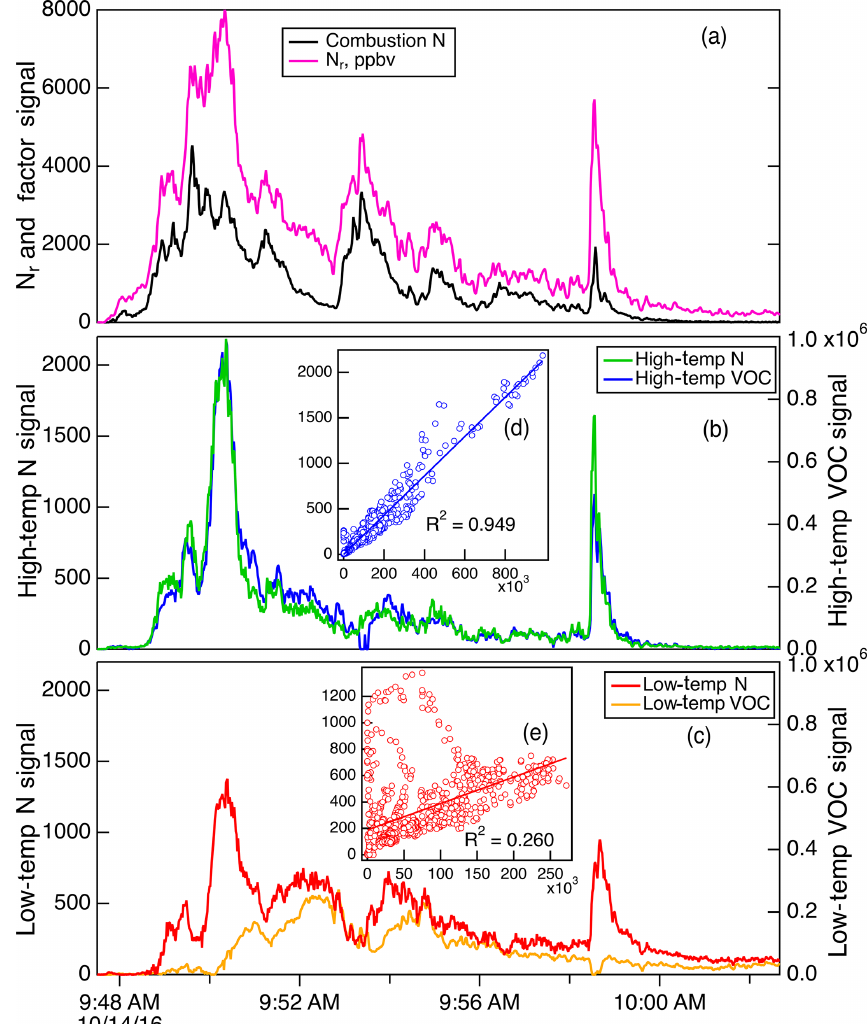
Figure 11. Details of the PMF factors for Fire 037 (ponderosa pine). Panel (a) shows the total N r signal (magenta) and the Comb-N factor (black); panel (b) shows the HT-N factor (green) and HT- VOC factor (blue), and panel (c) shows the LT-N factor (red) and LT-VOC factor (orange). The insets (d) and (e) show the correlation of the two HT factors and the correlation between the two LT factors,